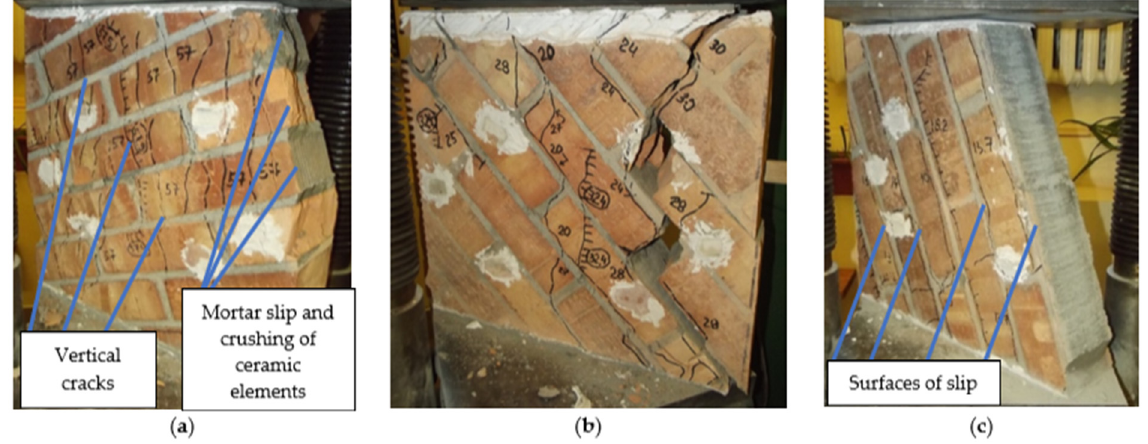
Figure 13. Mechanism of failure of wall specimens θ = 22.5°, ( a ) θ = 45°, ( b ) and θ = 67.5° ( c